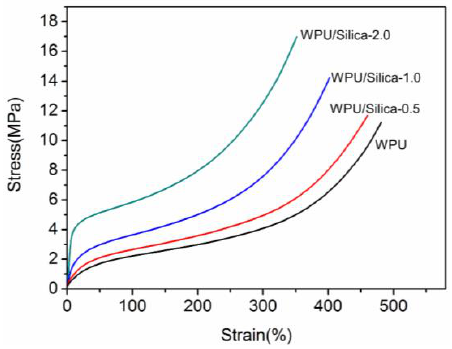
Figure 11. Stress-strain curves of WPU and WPU/Silica coatings.